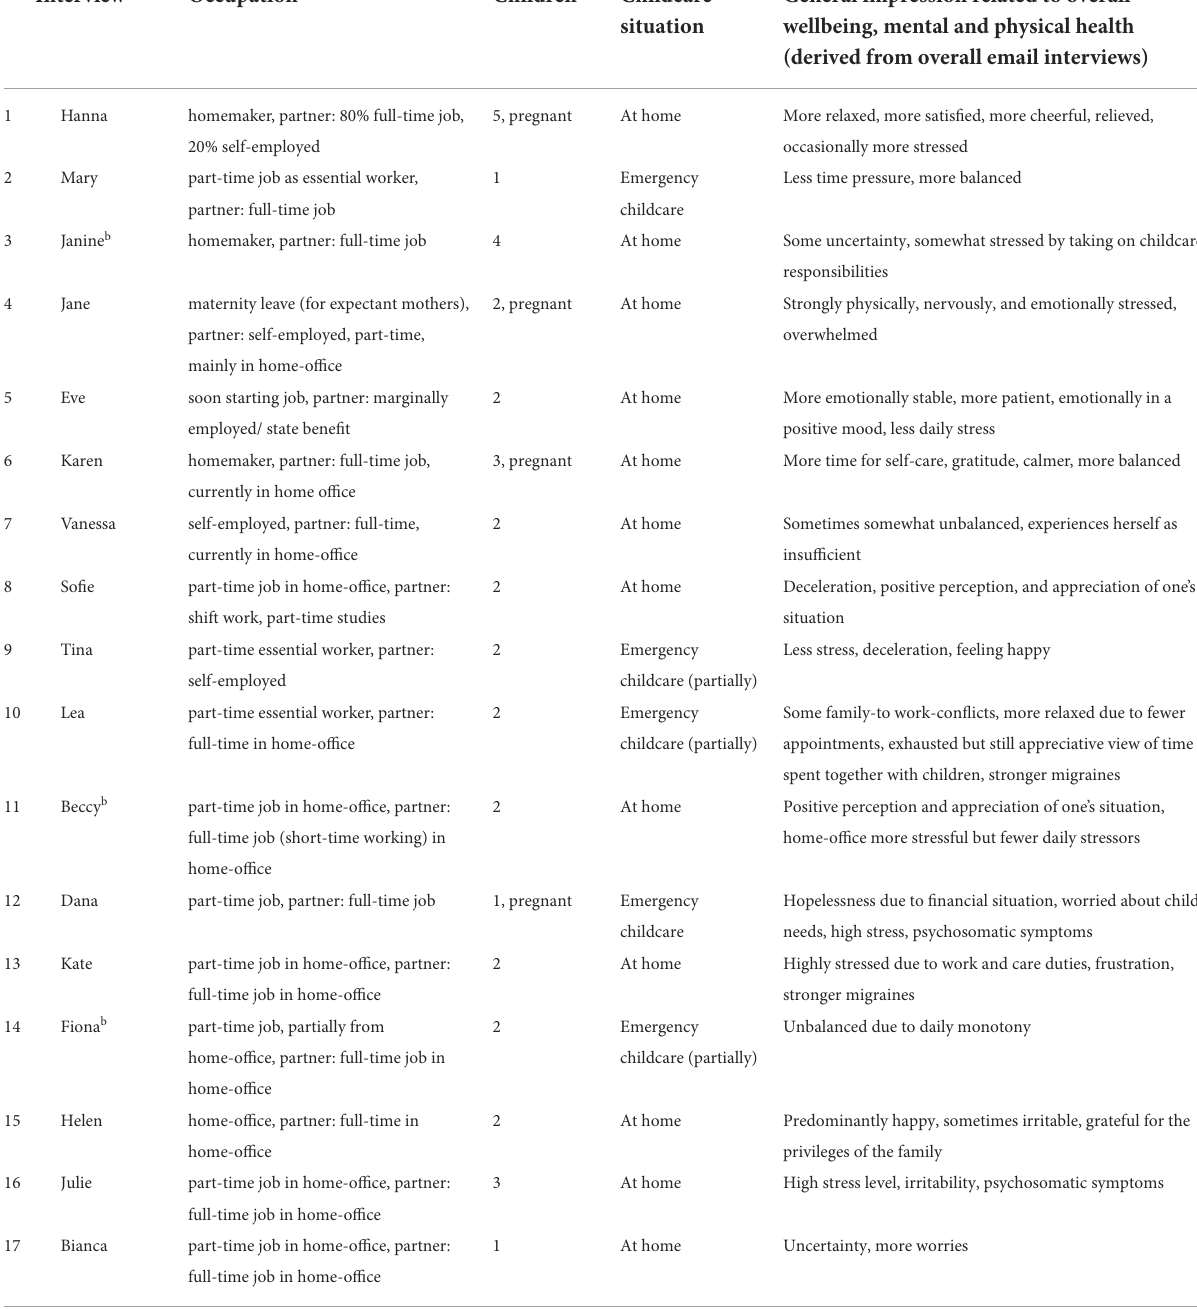
TABLE 2 List of interviewees by name, information derived from email-interviews. Interview